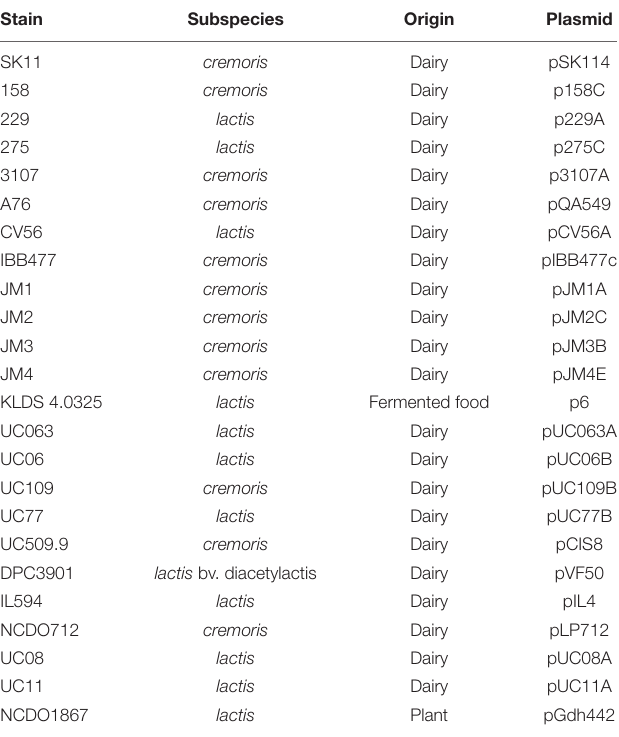
TABLE 2 | Overview of presence of plasmid-encoded lac / opp operons.